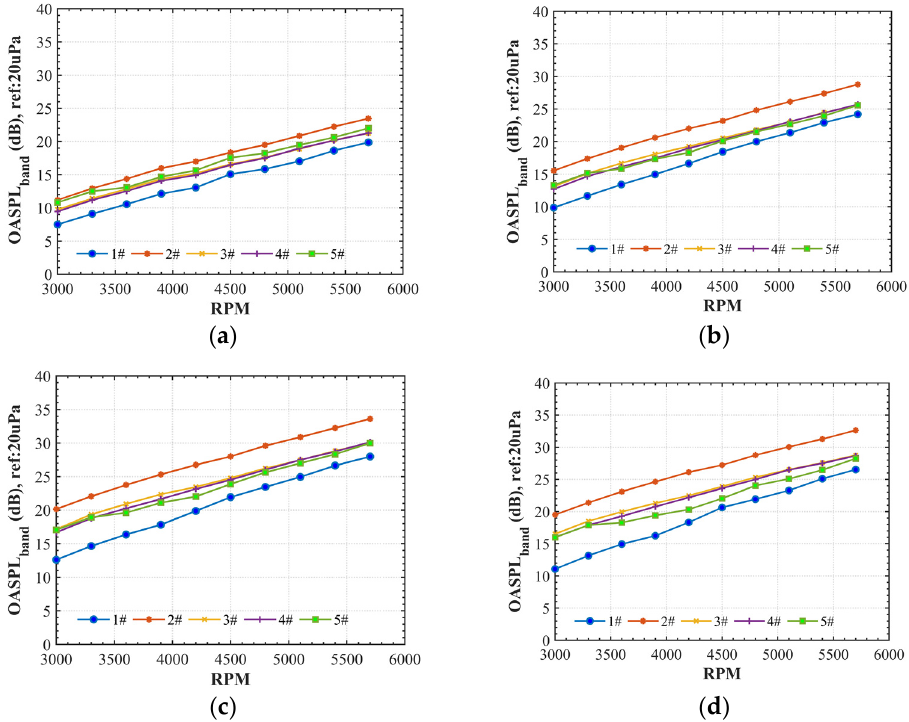
Figure 12. Comparison of the average broadband noise ( OASPL band ) beyond 6000 Hz vs. rotation speed at four locations of Mic 1 ( a ), Mic 2 ( b ), Mic 3 ( c ), and Mic 4 ( d ).